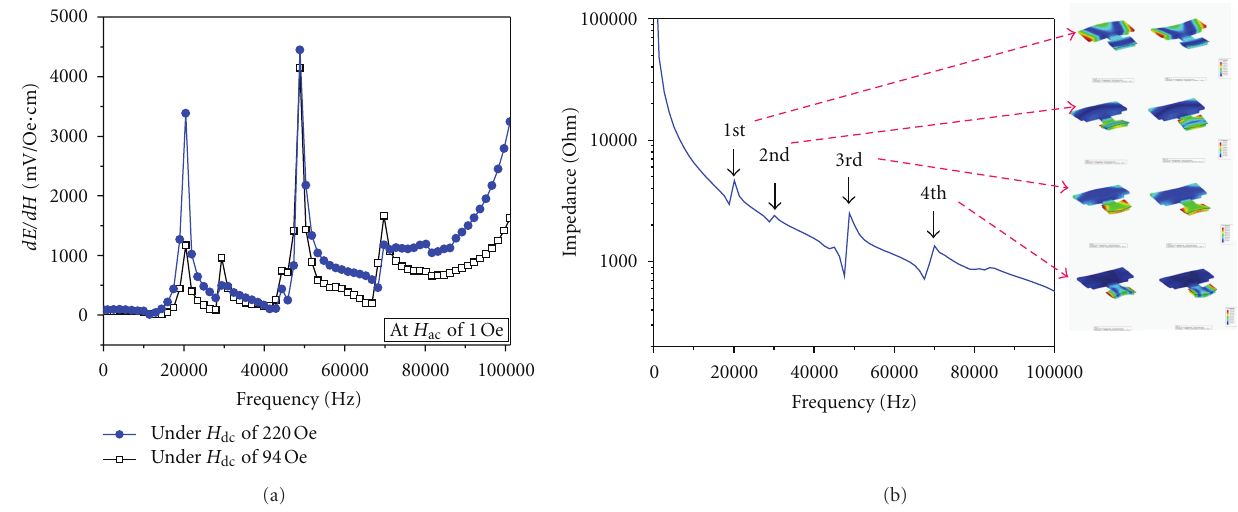
Figure 9: (a) Frequency dependence of the ME coe ffi cient for broadband laminate composite. Measurements were conducted under H ac = 1Oe and H dc = 94 and 220 Oe. (b) Impedance spectrum and FEM analysis of bending resonance modes corresponding to the peak ME responses [11].